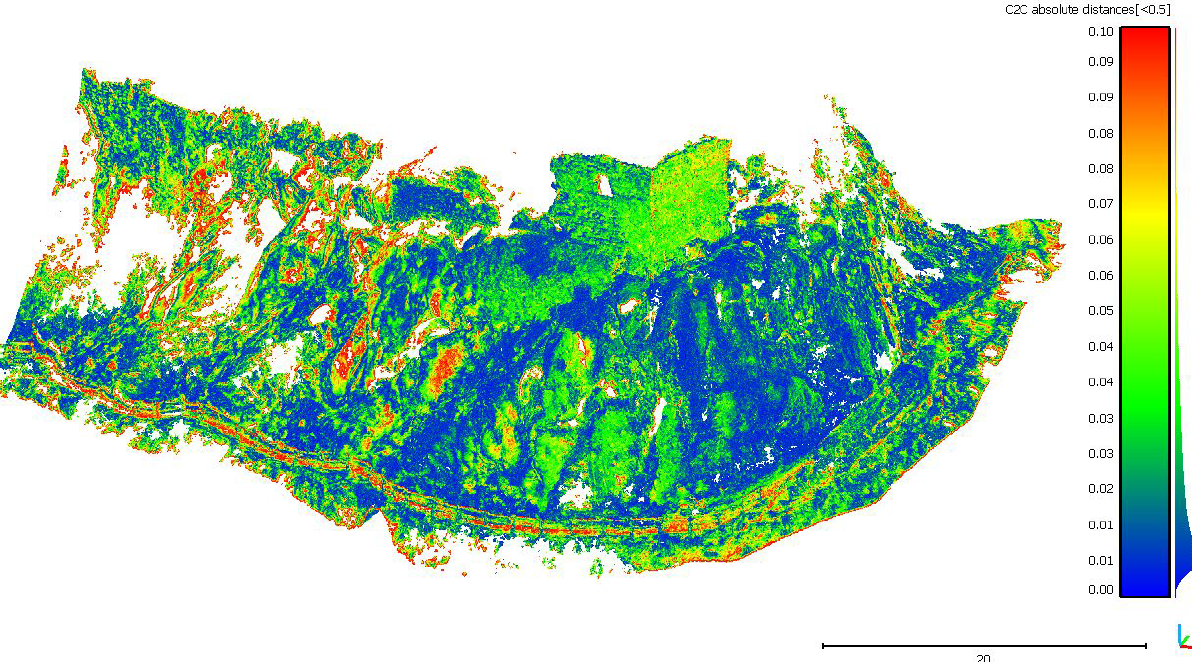
Figure 7. Differences between RPAS and TLS point clouds by CloudCompare shown in metres (modus of differences is at about 0.01m). Table 2. Rock mechanical tests and relevant standards. Rock mechanical